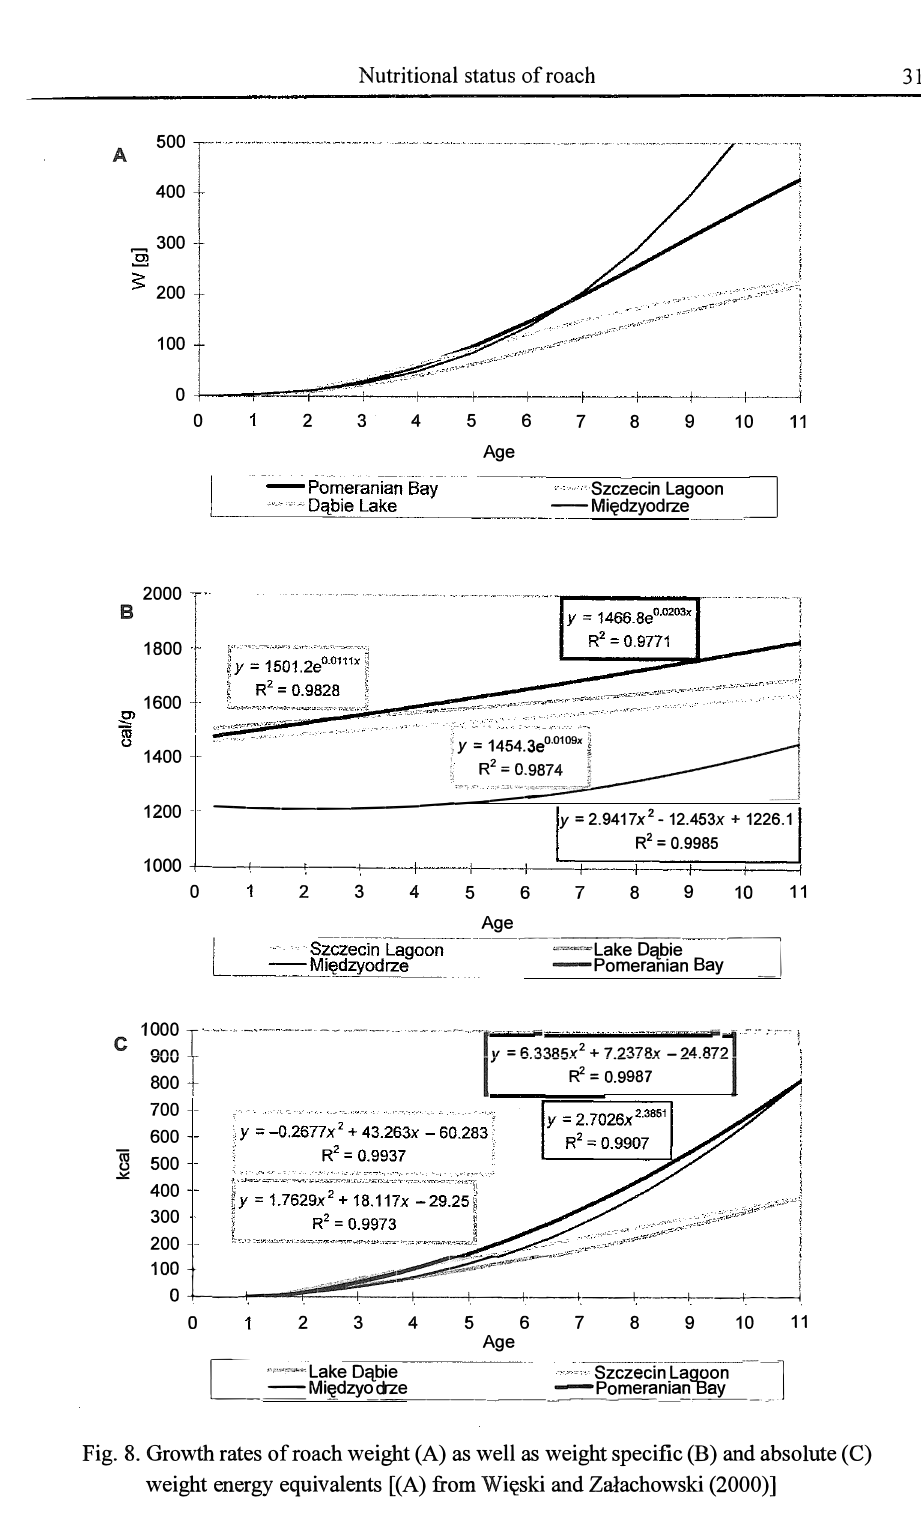
Fig. 8. Growth rates of roach weight (A) as well as weight specific (B) and absolute (C) weight energy equivalents [(A) from Wif,ski and Zalachowski